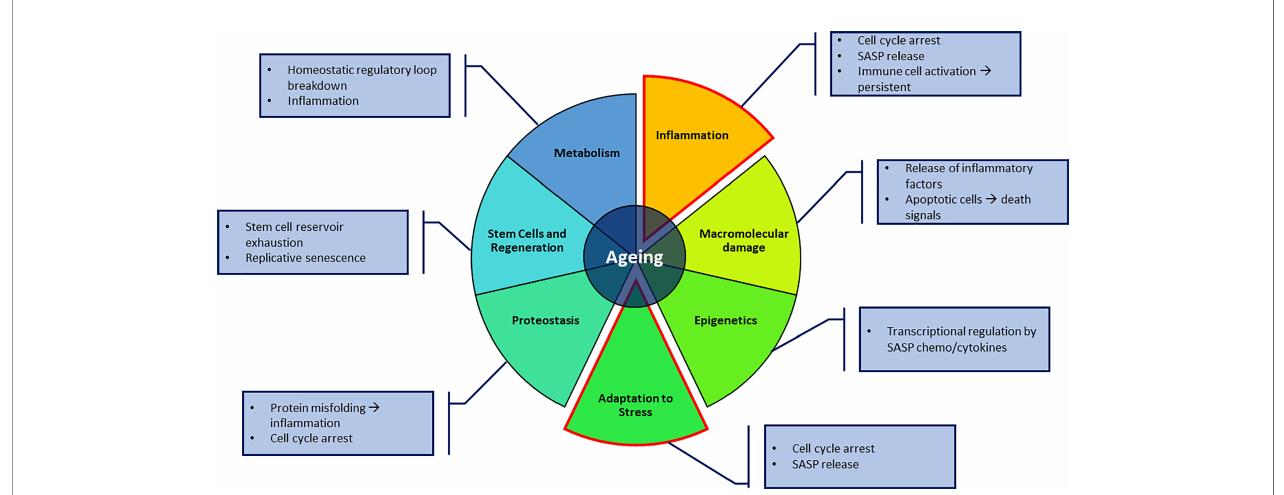
FIGURE 1 | The seven pillars of ageing proposed by Kennedy et al. (4). Key aspects in this review focus on the adaptation to stressful environments in the form of senescence and macrophages, and the in fl ammatory effect it can have on its surroundings. Annotations to each pillar highlight possible contributions to direct senescence or producing a senescence-promoting